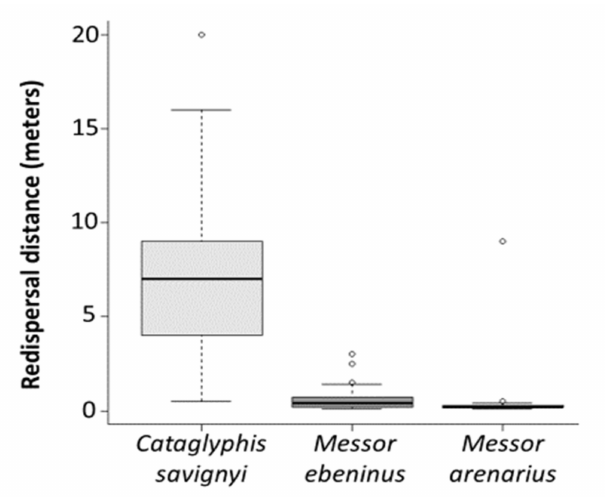
Figure 2. Seed redispersal distance by each ant species. Each boxplot represents the median (black horizontal line), 25, and 75 quartiles. The error lines as described in Figure 1.